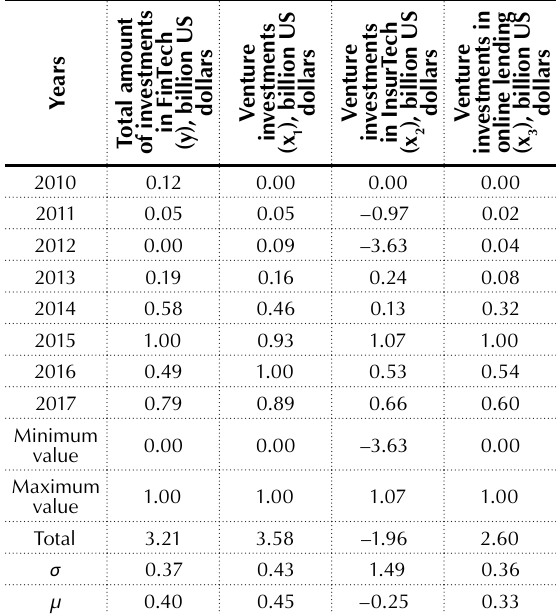
Table 3. Output data for the regression model corrected by the method of natural